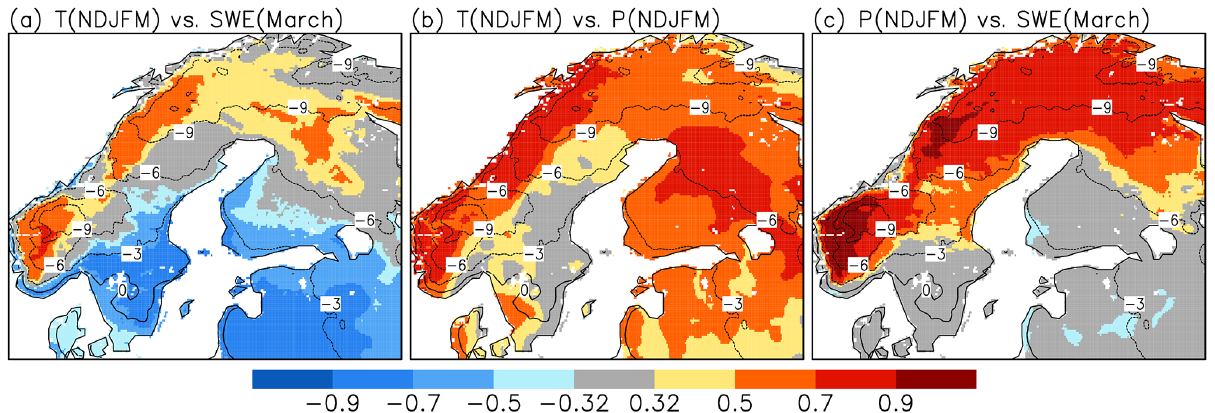
Figure 2. Correlation between (a) the NDJFM mean temperature and the March mean SWE, (b) the NDJFM mean temperature and precipi- tation, and (c) the NDJFM mean precipitation and the March mean SWE in winters 1981/82 to 2019/20. Correlations not significant at 5% level ( | r | < 0 . 32) are shown in grey. The contours show the 39-winter mean NDJFM temperature based on